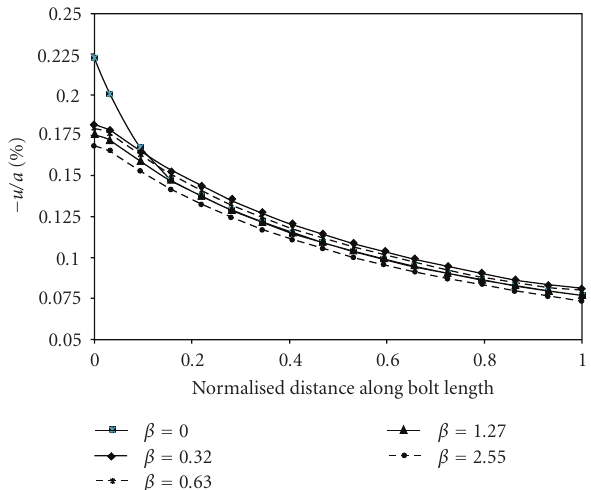
Figure 17: Distributions of radial displacements in rock mass (with faceplate) with bolt density.